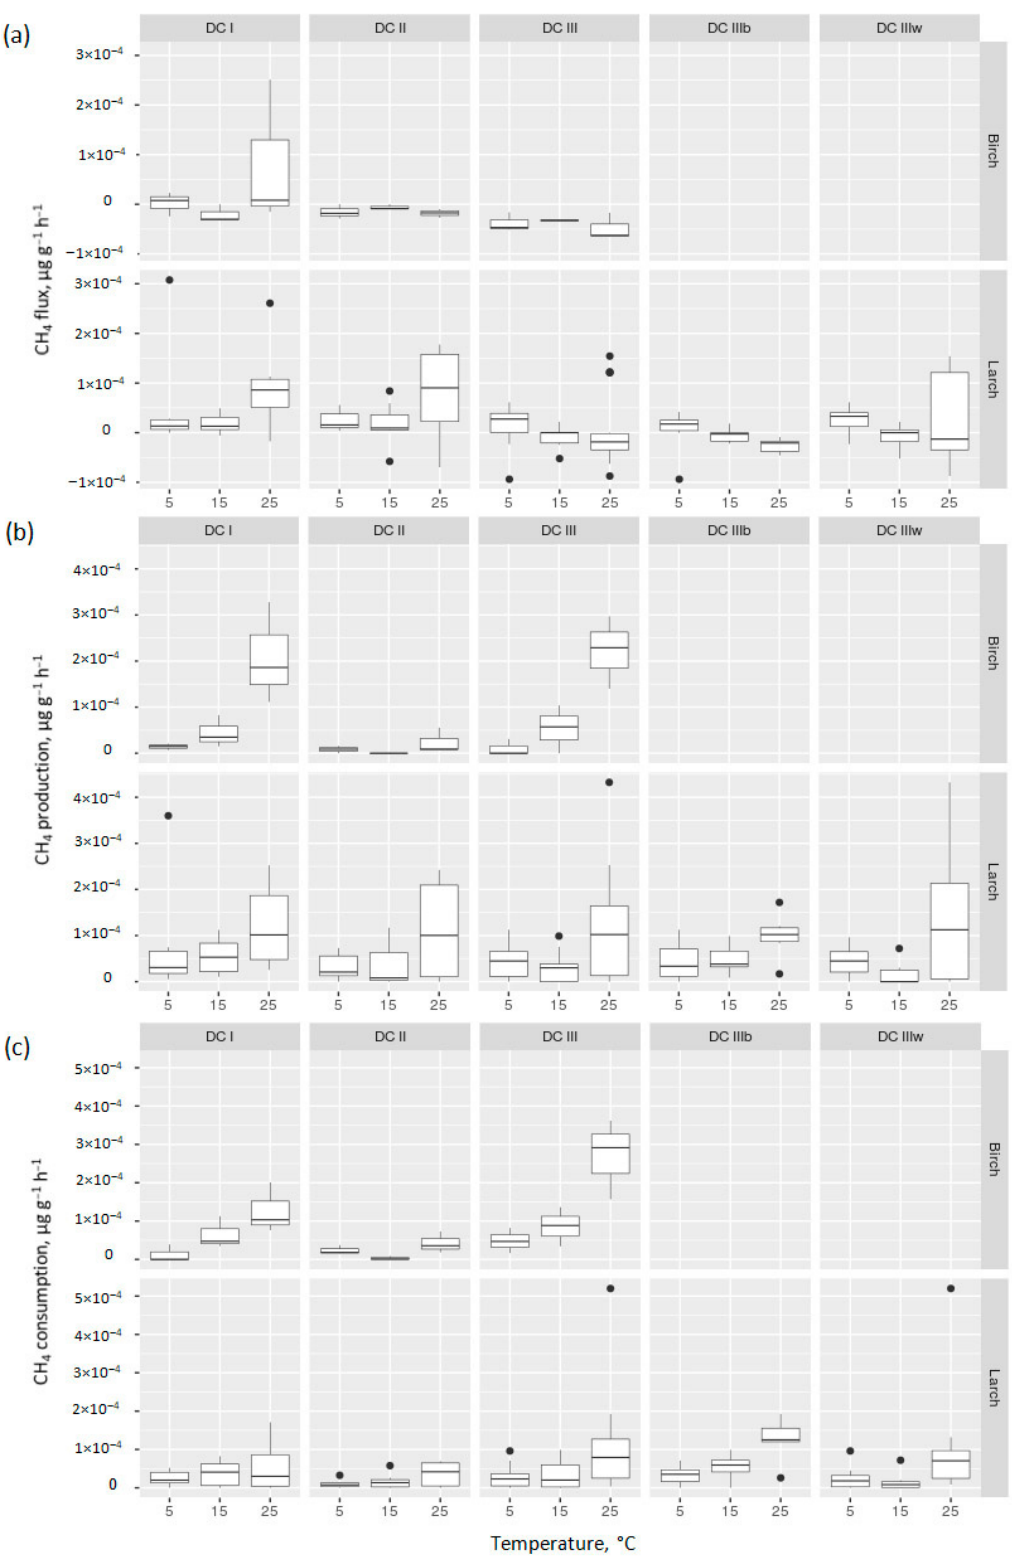
Figure 2. The rate of CH 4 flux ( a ), CH 4 production ( b ) and CH 4 consumption ( c ) during decomposition of larch (Larch) and birch (Birch) wood shown as box plots: DC I–DC III—decomposition classes I–III; DC IIIw—separately larch wood of DC III decomposed by white rot fungi; DC IIIb—separately larch wood of DC III decomposed by brown rot. CH 4 consumption ( c ) was calculated as a difference between CH 4 production ( b ) and CH 4 flux ( a ).